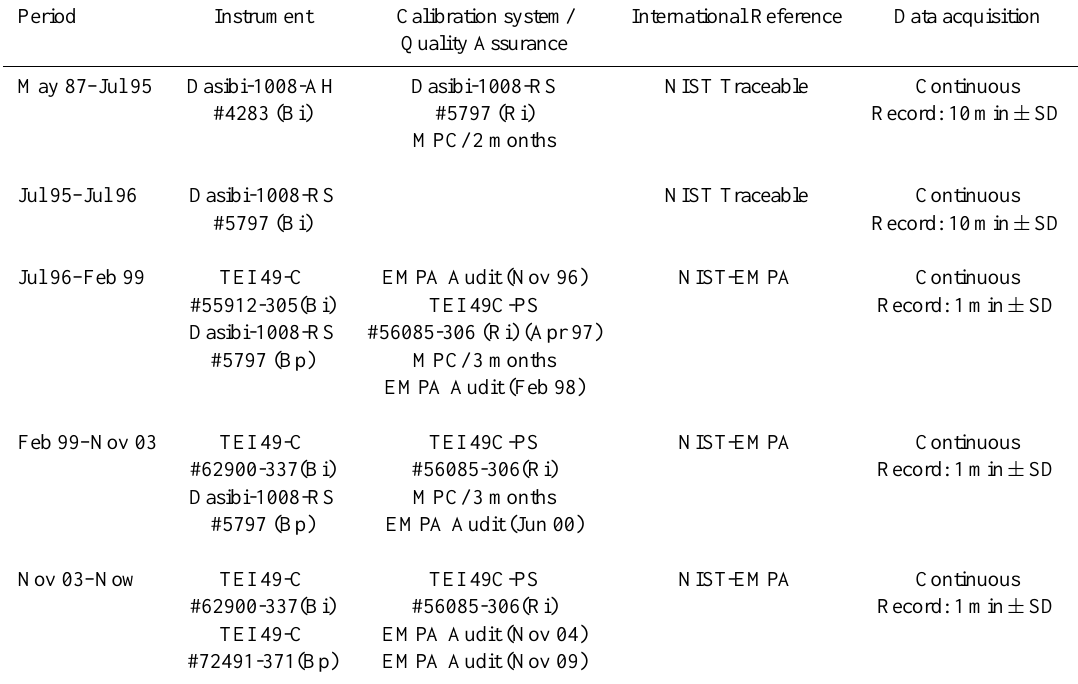
Table 1. Description of O 3 analysers, associated quality assurance, and data acquisition system used during the period 1988–2009. Ri=Reference instrument; Bi=Basic instrument; Bp=Backup instrument; MPC=Multipoint calibration.